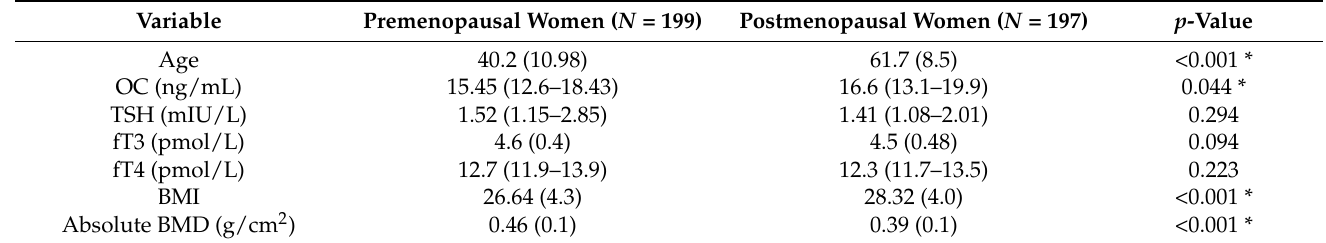
Table 3. Clinical characteristics of premenopausal and postmenopausal